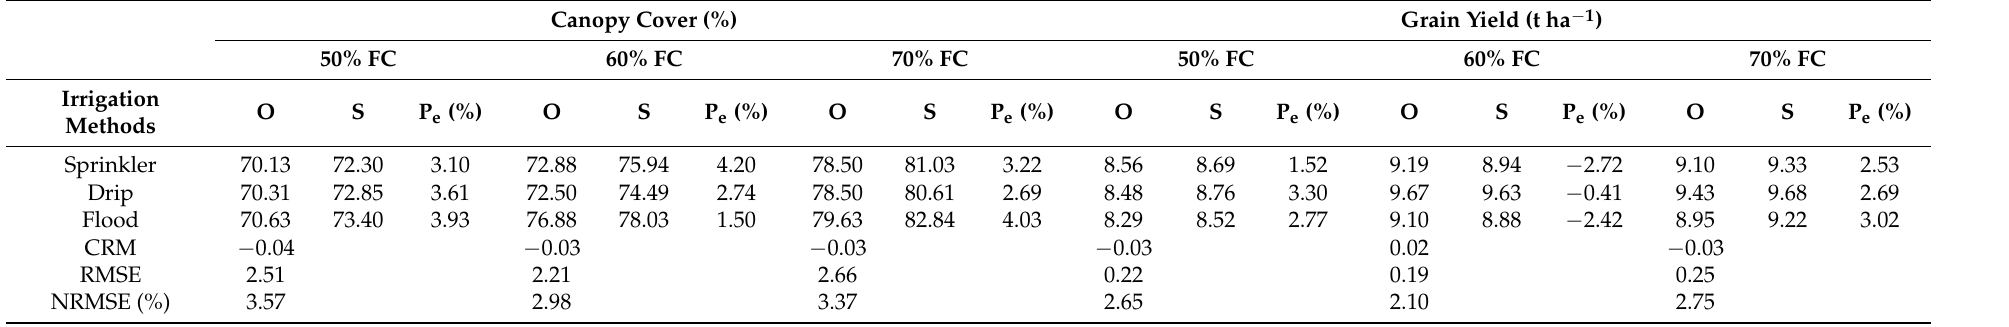
Table 5. Calibration results of canopy cover and grain yield of winter wheat during the 2016–2017 season.